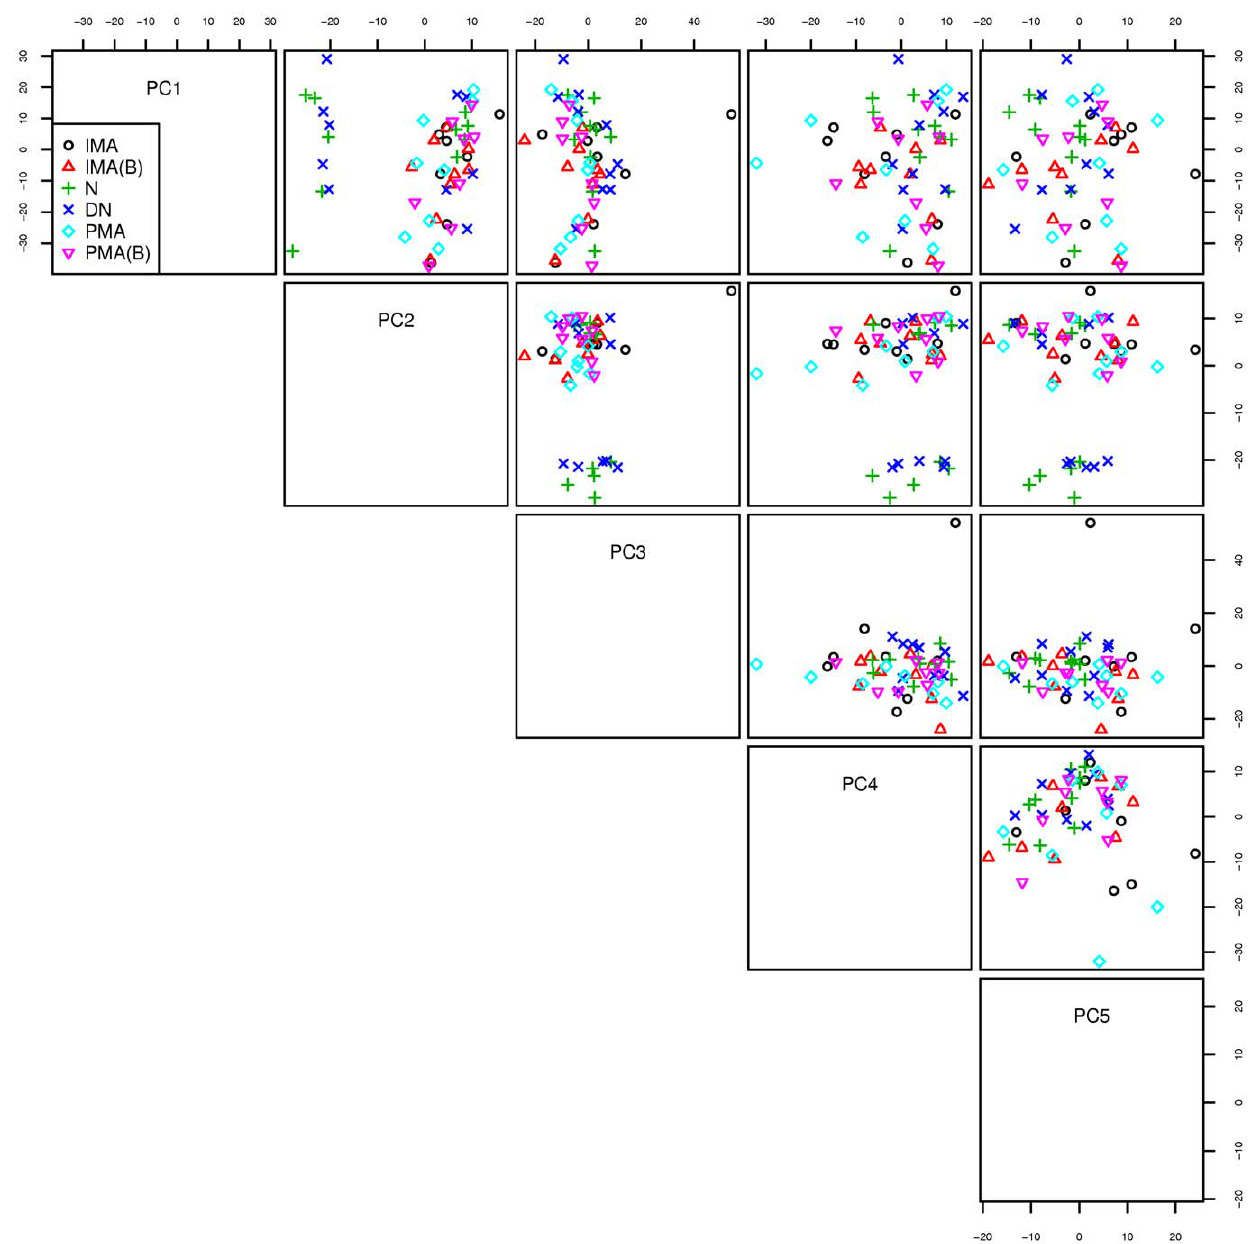
Figure 2. Results of Principal Component Analysis applied to all urine samples analyzed in this study. To present the results of the five dimensional PCA, we utilized bivariate projections in which each component is plotted against all e.g. the second plot in the first row plots the first principal component (PC1) against the second (PC2). Each individual urine sample is color and symbol coded according to the disease classification at the time it was collected. N: patients without nephropathy, DN: patients with overt nephropathy, IMA(B): normoalbuminuric samples from patients who had intermittent microalbuminuria, PMA(B): last normoalbuminuric samples from patients who had persistent albuminuria, IMA: micro- albuminuric samples from patients who had intermittent micro-albuminuria, PMA: micro-albuminuric samples from patients who had persistent microalbuminuria.